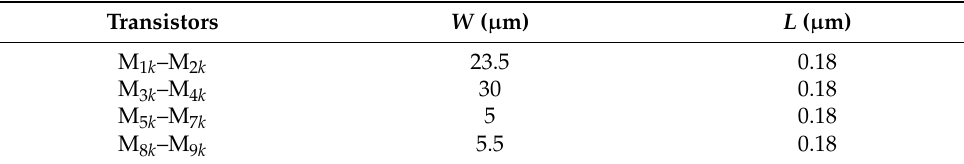
Figure 4. CMOS circuit of the VDGA used in simulation. Table 3. Transistor dimensions of VDGA in Figure 4.